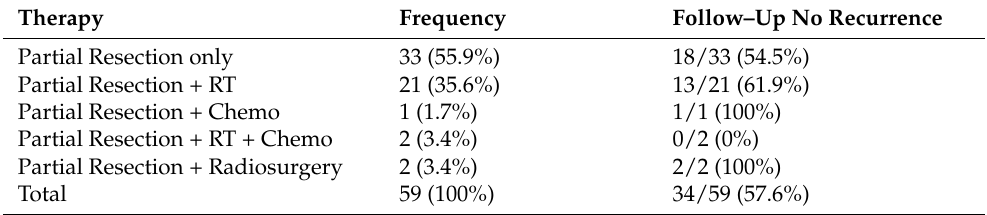
Table 3. Partial Resection and Follow–Up Data: Partial Resection alone shows a high recurrence rate. The combination with adjuvant radiotherapy leads to more promising